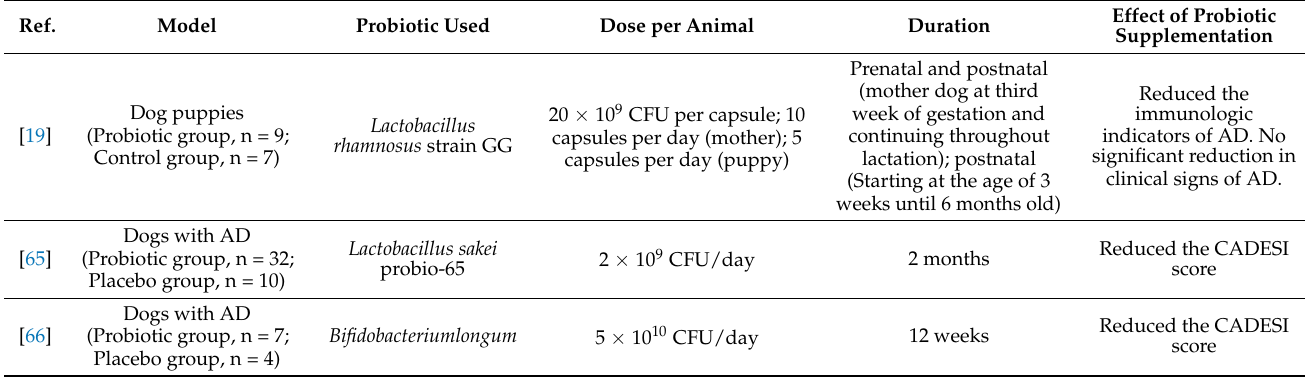
Table 3. The effects of probiotic supplementation on the health status of dogs with atopic dermatitis.